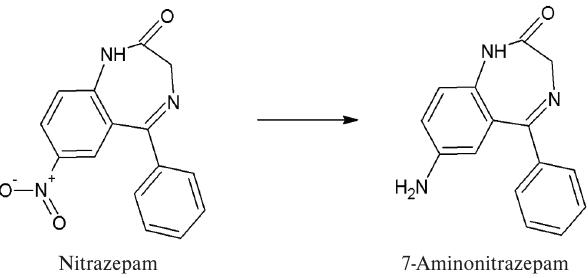
Fig. 2. Nitro reduction of nitrazepam catalyzed by the gut bacterial enzymes produce teratogenic metabolite, 7-aminonitrazepam. it is an example of clinically undesirable side effect caused by the gut